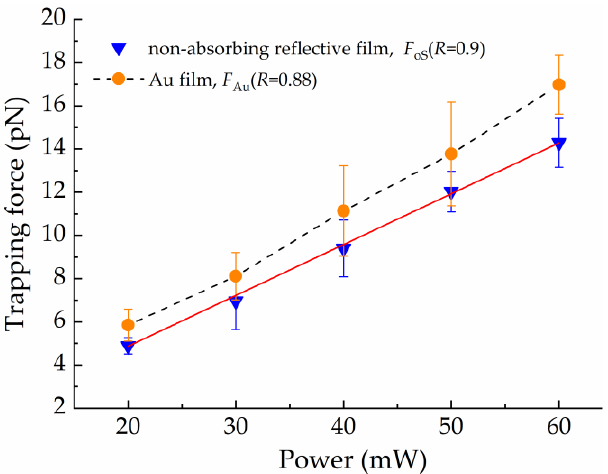
Figure 3. Transverse trapping force as a function of laser power at two different sample cells, which constructed with a non-absorbing reflective film ( R = 0.9), or a gold film as the substrates, respectively. F oS , optical trapping force of stand-wave trap; F Au , optothermal trapping force close to a gold film. When the laser power was less than 20 mW, the optothermal trapping was not